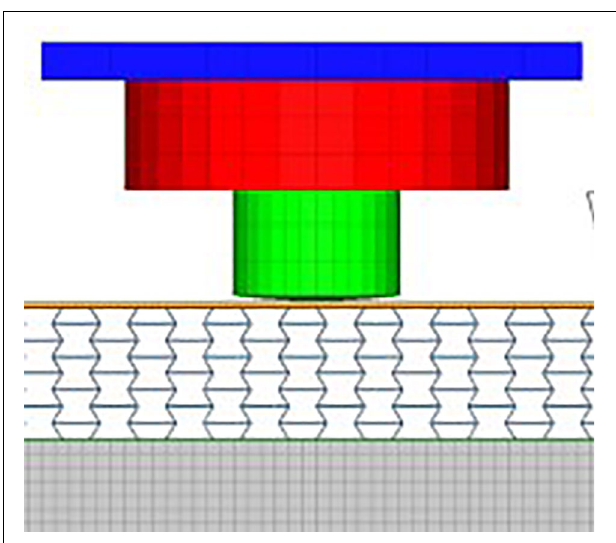
FIGURE 14 | Honeycomb-like structural sandwich for impact absorption (Qi et al., 2017).